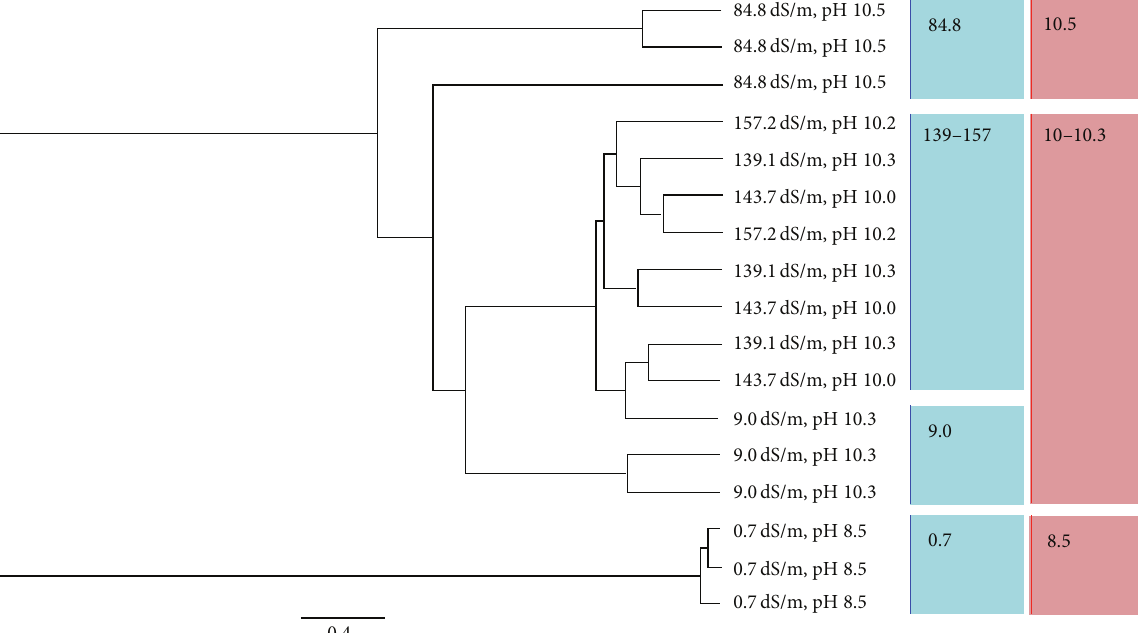
Figure 4: UPGMA jackknifed clustering of the UniFrac weighted distances for rarefied 1200-sequence reads ( 𝑛 = 17 ) of the archaeal communities from alkaline-saline soils of the former lake Texcoco with different electrolytic conductivity and pH. The scale bar represents 0.4% of divergence UniFrac over all sites